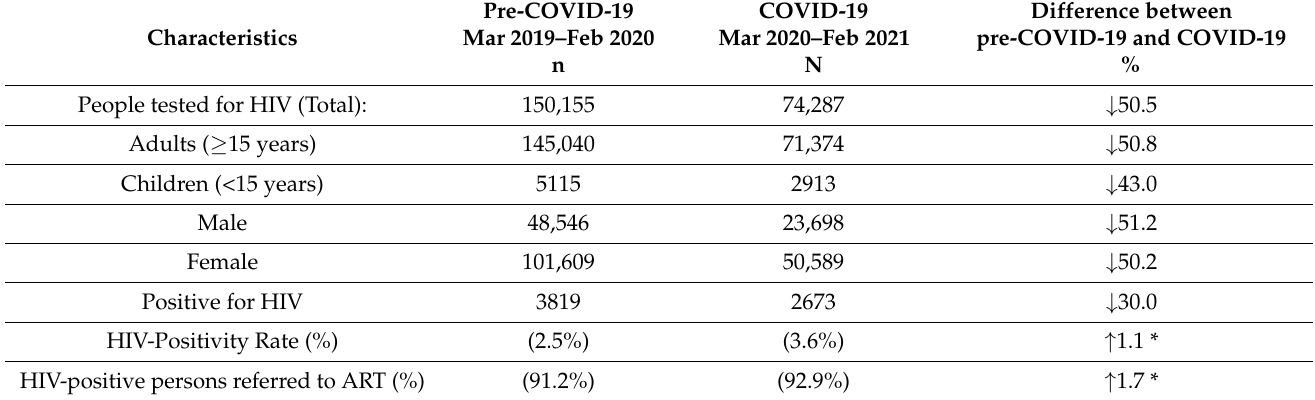
Table 3. Characteristics of persons tested for HIV and referred for antiretroviral therapy in 18 health facilities in Nairobi, Kenya, during pre-COVID-19 and COVID-19 periods.